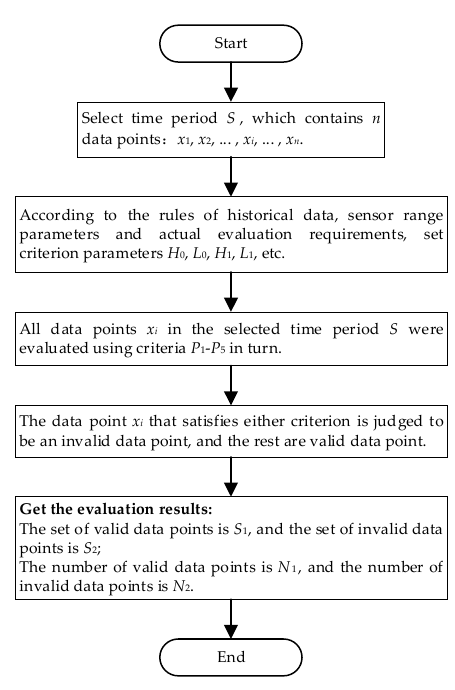
Figure 11. Data validity evaluation process.